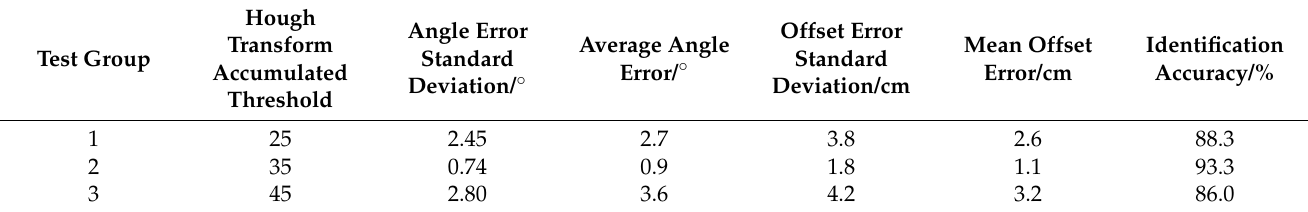
Table 2. Accuracy test.